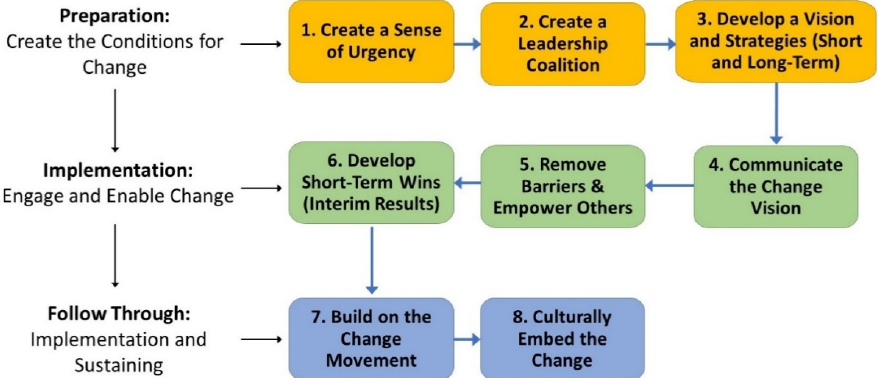
Figure 1. The three phases of organizational change: Preparation, Implementation, and Follow Through (left). Eight phased integrated steps for organizational change (right), revised and recreated from Kotter (2012). Figure used with permission from Hubbart (2022).